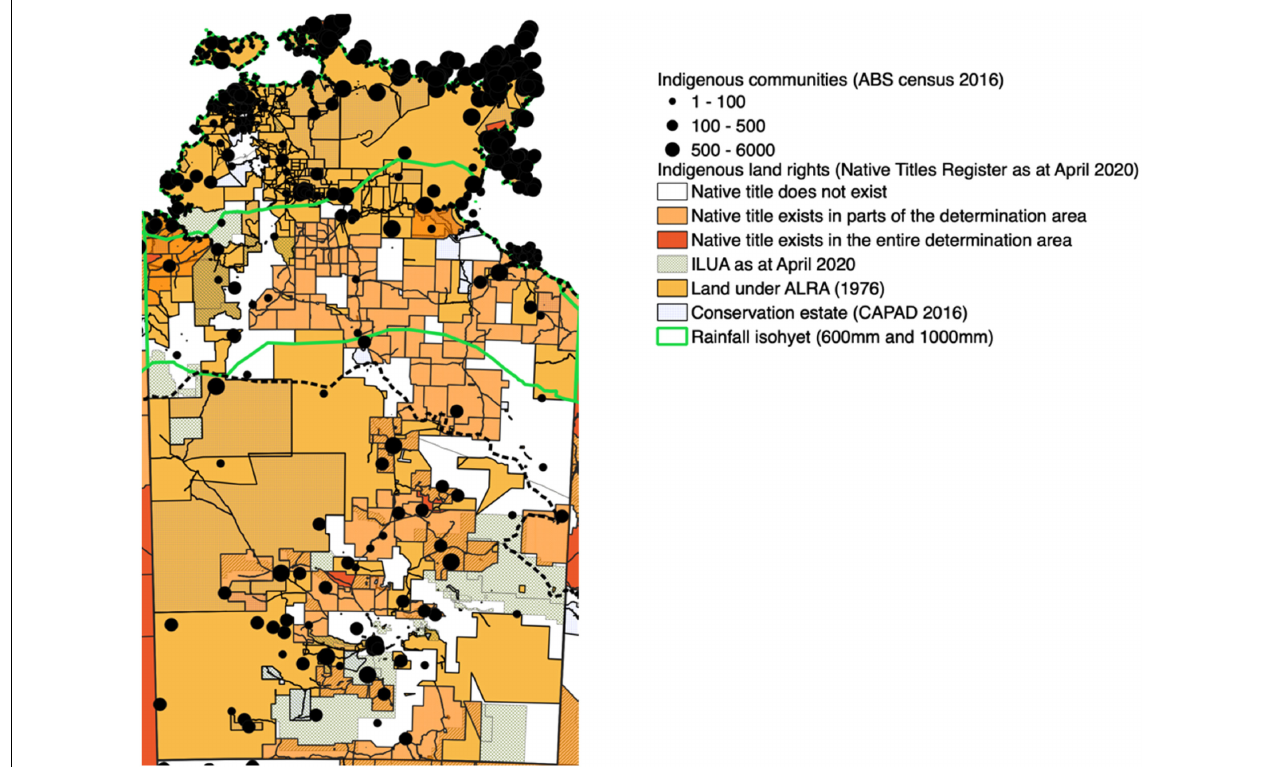
FIGURE 3 | Indigenous land rights and distribution of communities across the NT, Australia.